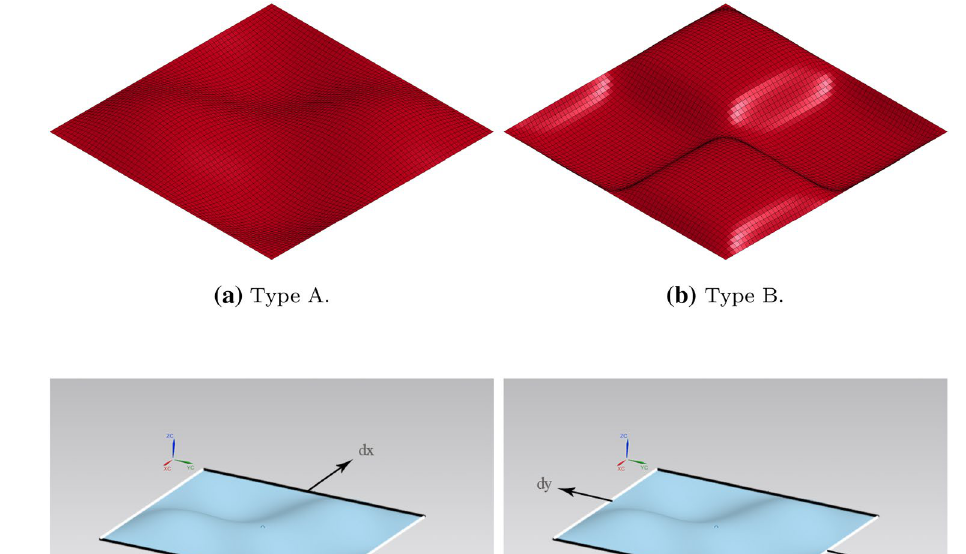
Fig. 8 Load cases for determin- ing constants of the ABD- matrix presented in Eq.